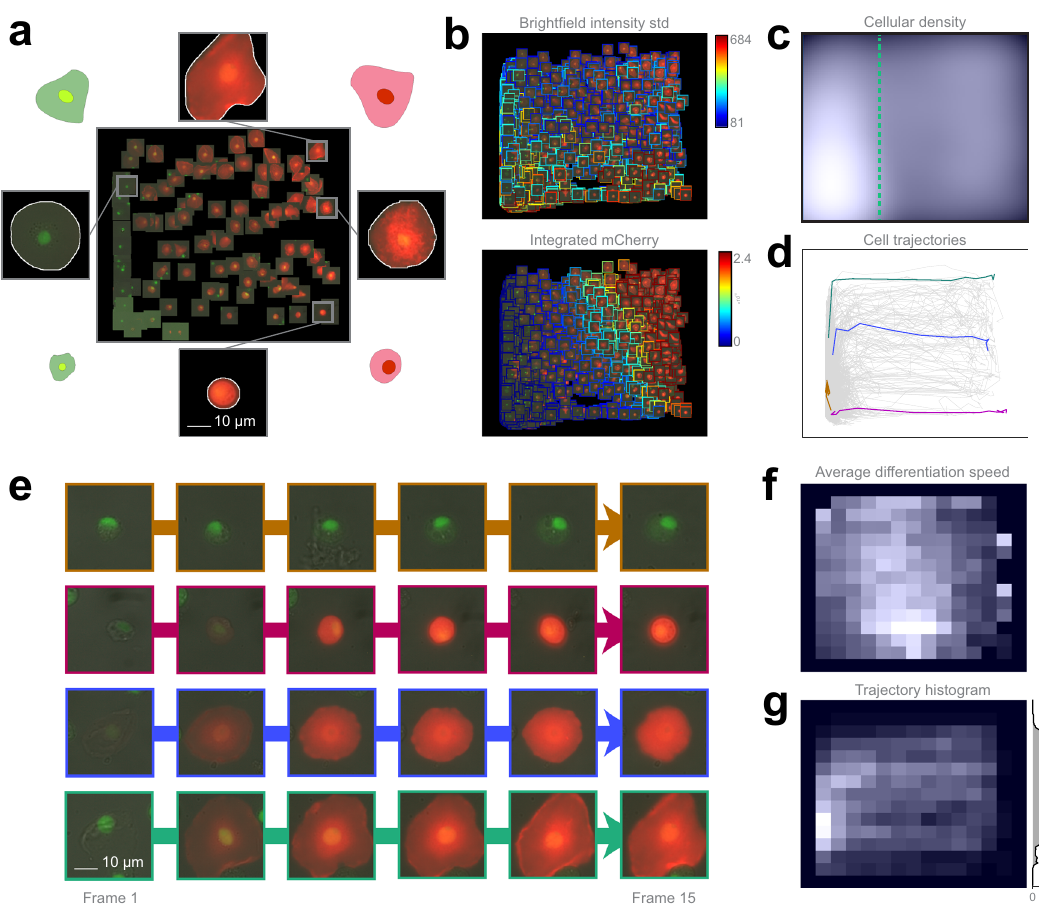
Fig. 4 Hemocyte dataset analysis. a Training set. 109 cells were placed on the regression plane by a microscopy expert. Cells were segmented by applying the NucleAIzer 40 deep learning method on bright fi eld microscopy images. b Single cell features. Colour-coded feature values overlay on the predicted cells. c Density plots. Kernel density estimation of single cells. d Single-cell trajectories. 2323 cell trajectories on the regression plane. e Selected cell trajectories. Representative phenotypes highlighted in d . f Differentiation speed histogram. Cell differentiation speed on the regression plane. g Trajectory histogram. 2D trajectory histogram on the regression plane and 1D projection with trajectory counts, including only those trajectories that reach beyond the green line in c